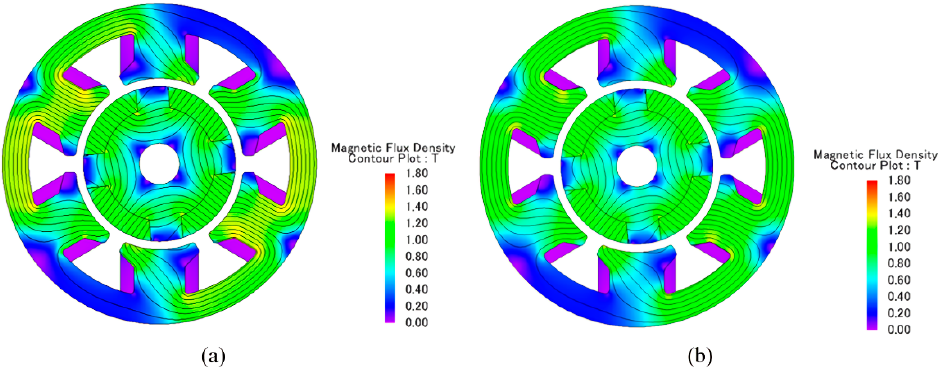
Figure 8. Magnetic flux density distributions of ( a ) 35CS300 and ( b ) Somaloy 1000 3P in improved motor designs at maximum torques. Table 5. Theoretical properties of 35CS300 and Somaloy 1000 3P motors .